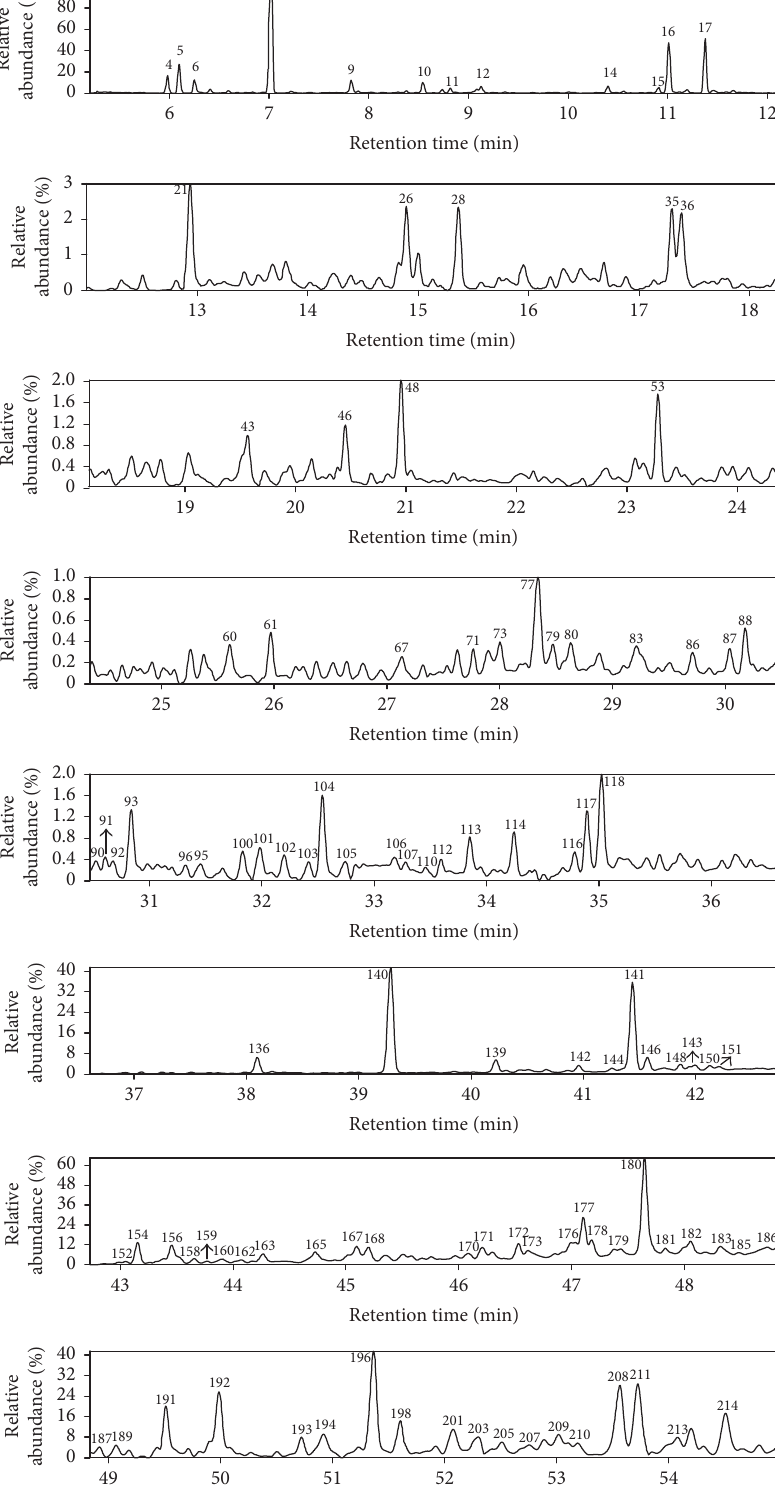
Figure 2: Total ion chromatogram of the reaction product from NCHC of